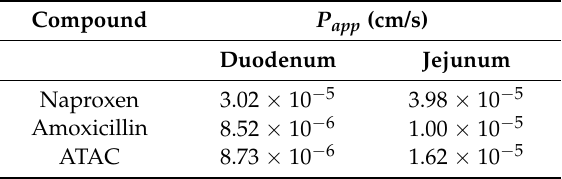
Table 2. Permeability of Compound 1 in the everted rat gut model.